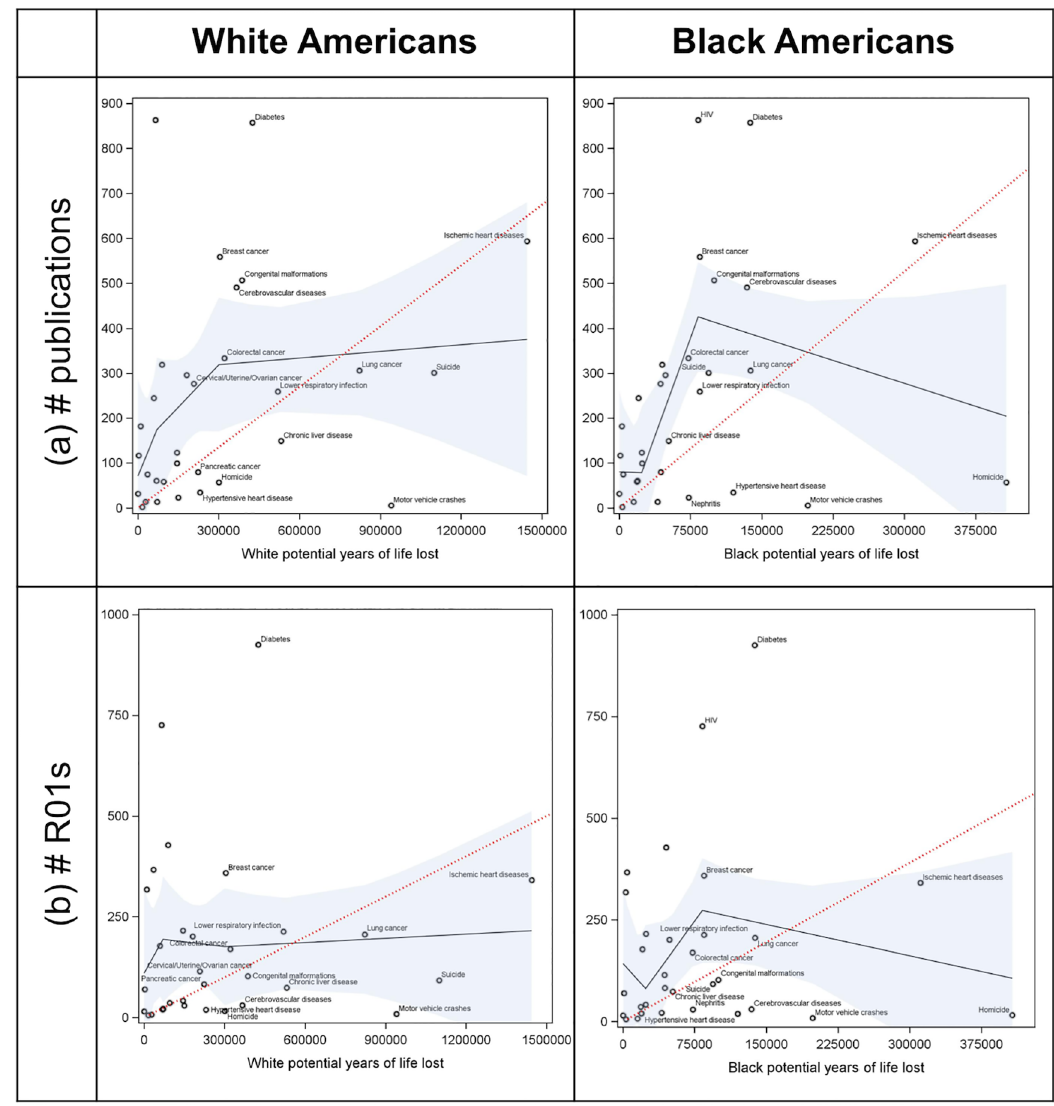
Fig 3. The relationship between the number of potential yearsof life lost (PYLL) due to 31 causes of death in all 2015 US deaths and (a) the number of journal articles written about the cause of death and (b) the number of NIH funded R01 grants about the cause of death, stratified by black and white race. Solid black line shows predicted relationships from linear splineregressionmodels with nodes at tertiles and 95% confidencelimits in blue. Dotted red reference line shows hypothetical relationship if every 1% increasein PYLL correspondedwith a 1% increasein (a) publications and (b) funded grants. Top 15 race-specific contributors to PYLL are labeledin each panel.